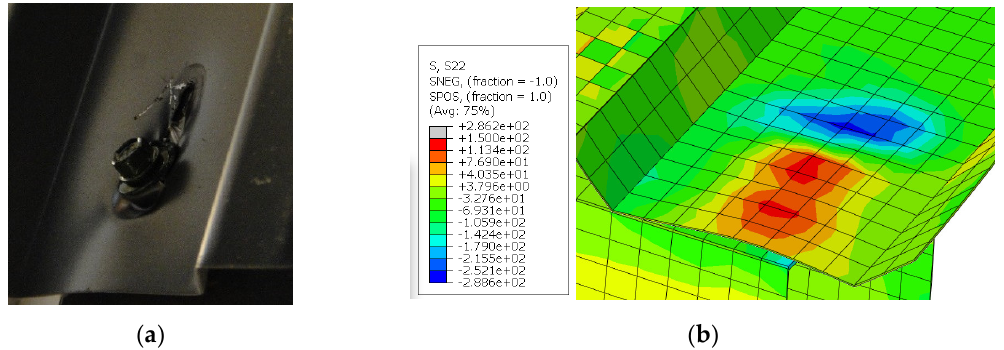
Figure 13. The comparison of the results in the area of self-drilling screw: ( a ) test, ( b ) numerical model (stresses in the direction parallel to the corrugation [MPa]).